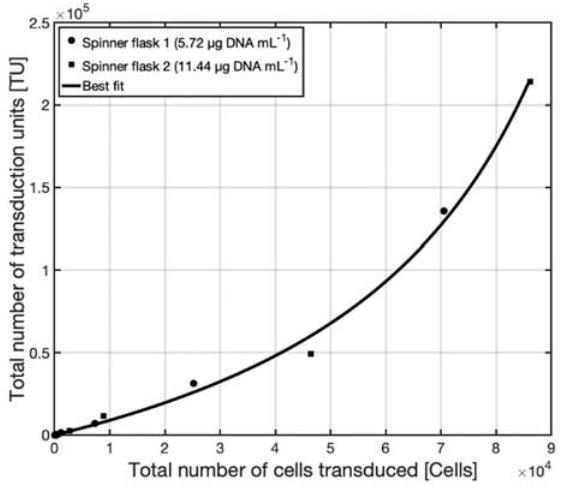
Figure 7. The total number of transduction units calculated from the titer determined by the TCID 50 assay, represented as a function of the total number of transduced CHO cells; approximation by model 𝑦 = 𝑏 𝑥 ( 𝑎 – x ) -1 , coefficients 𝑎 = 128,900 and 𝑏 = 107,100 determined by linear regression.